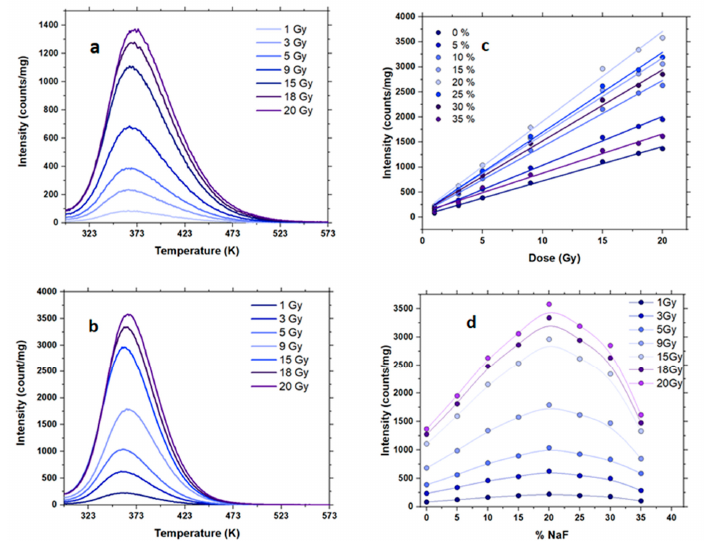
Figure 4. ( a ) Sample with x = 0% irradiated at different irradiation doses. ( b ) Representative sample with x = 20% irradiated at different irradiation doses. ( c ) Intensity as a function of different irradiation doses for different samples. ( d ) Variation of the intensity as a function of different concentrations of NaF for different irradiated samples. To interpret and analyze the kinetic of the TL glow curve, we used a different ap- proach found in the literature. First, we analyzed the variation of the temperature of the peak maximum (T M ). From Figure 4a,b, it is possible to observe that the T M remains un- changed as the irradiation dose increases, which could be consistent with first-order ki- netics [31]. The same effect was observed for other samples (Supplementary Electronic Materials). To test the reaction order, we used the shape method [26,32]. In this method, few parameters were used: The T M , the temperature of the left side at half the height of the peak maximum, T 1 , the temperature of the right side at half the height of the peak